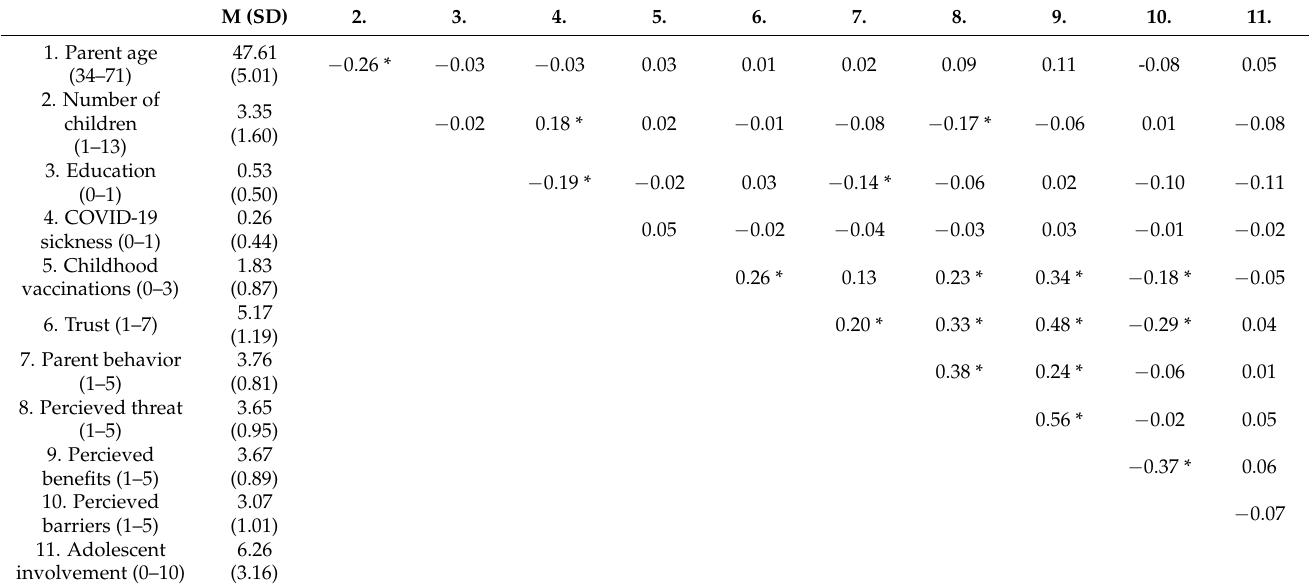
Table 1. Means, standard deviations, and intercorrelations for the independent variables ( n =